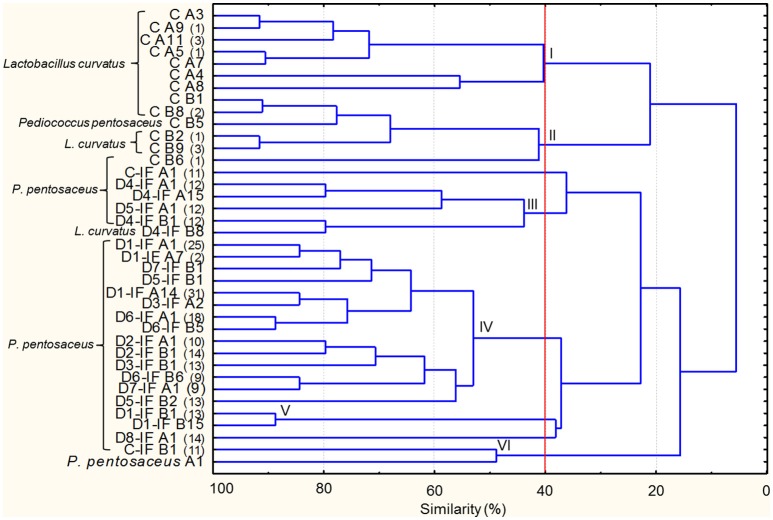
Dendrogram of combined (primers P4, P7, and M13) RAPD profiles of lactic acid bacterium strains isolated from the mature sourdoughs prepared with irradiated durum wheat flour (IF) or non-irradiated flour (C). The first letters (C or C-IF) or alphanumeric code (D1-IF, D2-IF, D3-IF, D4-IF, D5-IF, D6-IF, D7-IF, D8-IF) of the strain name indicates the sourdough of origin, whereas the following letter (separated by one space) of the strain name indicates the medium used for the isolation (A, mMRS; B, SDB). Where present, the numbers in brackets at right of the strain name indicates the number of isolates showing the same RAPD profile. Pediococcus pentosaceus A1 isolated from flour has been included in the dendrogram. Cluster analysis was based on UPGMA algorithm. Clusters are indicated by Roman numerals (I–VI).